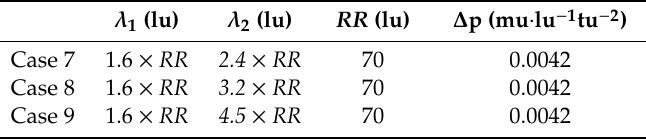
Table 3. Used parameters in Cases 7–9.